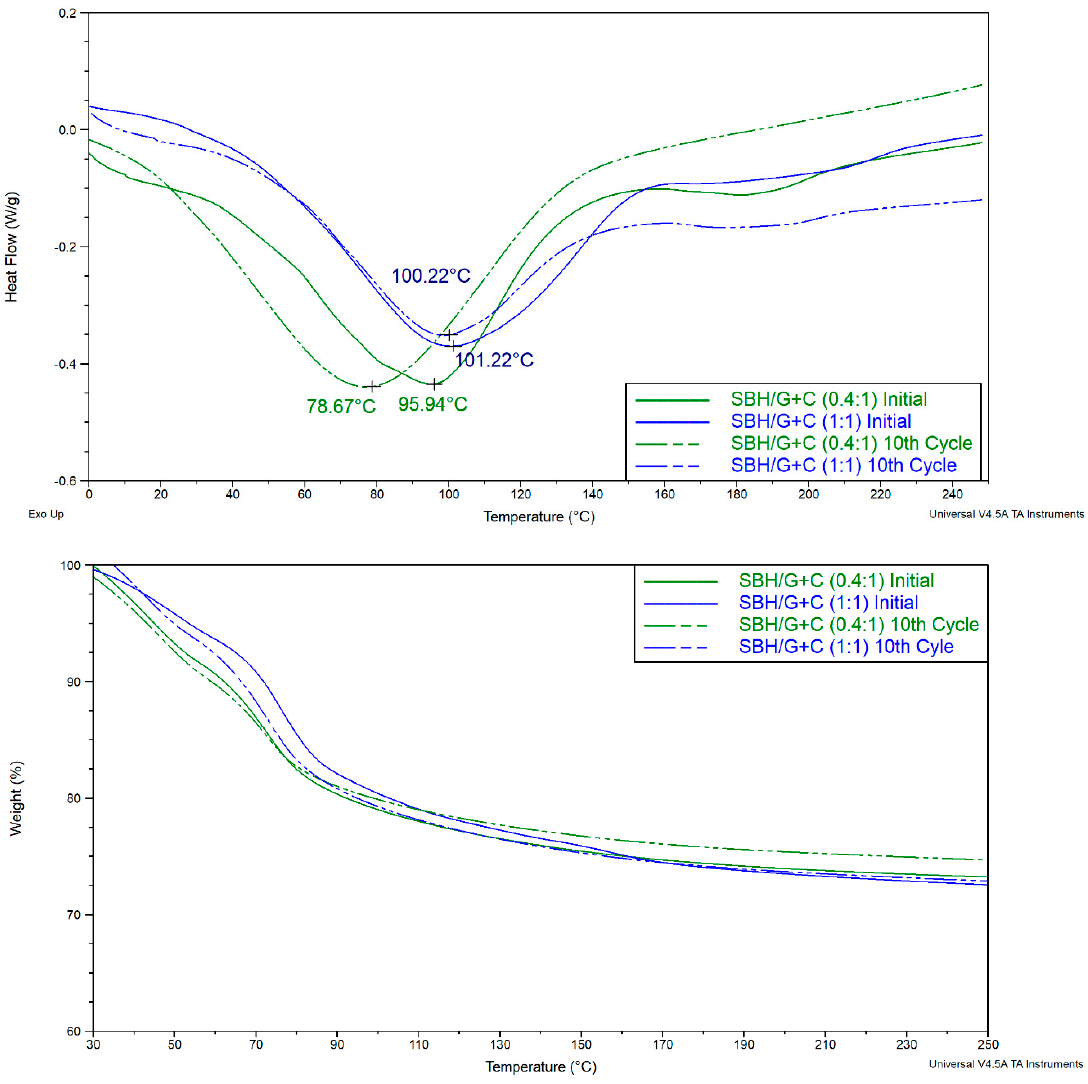
Figure 20. DSC (top) and TGA (bottom) charts of SBH / G + C pellets prepared under 5.2 kN · mm − 2 in a 25mm diameter.